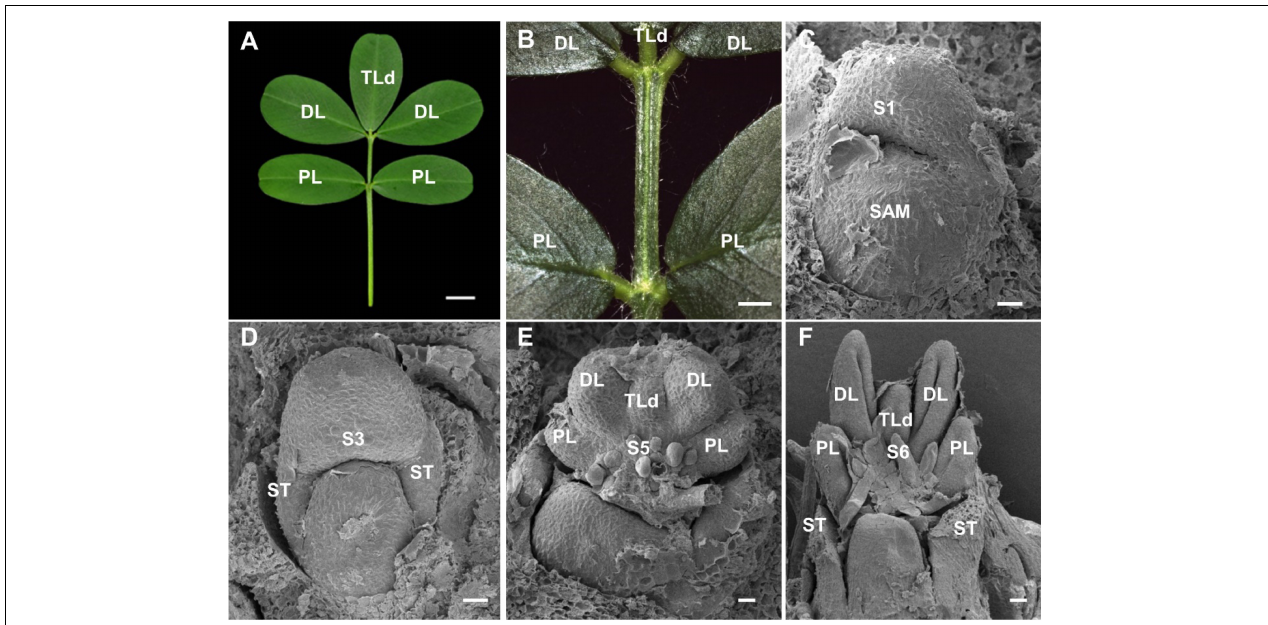
FIGURE 3 | Characterization of pentafoliate mutant in A. hypogaea . (A) About 46.1% of leaves showed pentafoliate leaf form in the mutant. (B) The close-up view of the leaf in panel (A) . (C,D) The leaf primordia were emerged at stage 1 (C) , and the stipule primordia were formed at stage 3 (D) . (E,F) Distally oriented terminal leaflet (TLd) primordium was emerged and developed between the distal leaflet primordia (DL) at stage 5 (E) and stage 6 (F) . Bars = 0.5 cm (A) , 0.2 cm in panel (B) , and 50 µ m in panels (C–F)